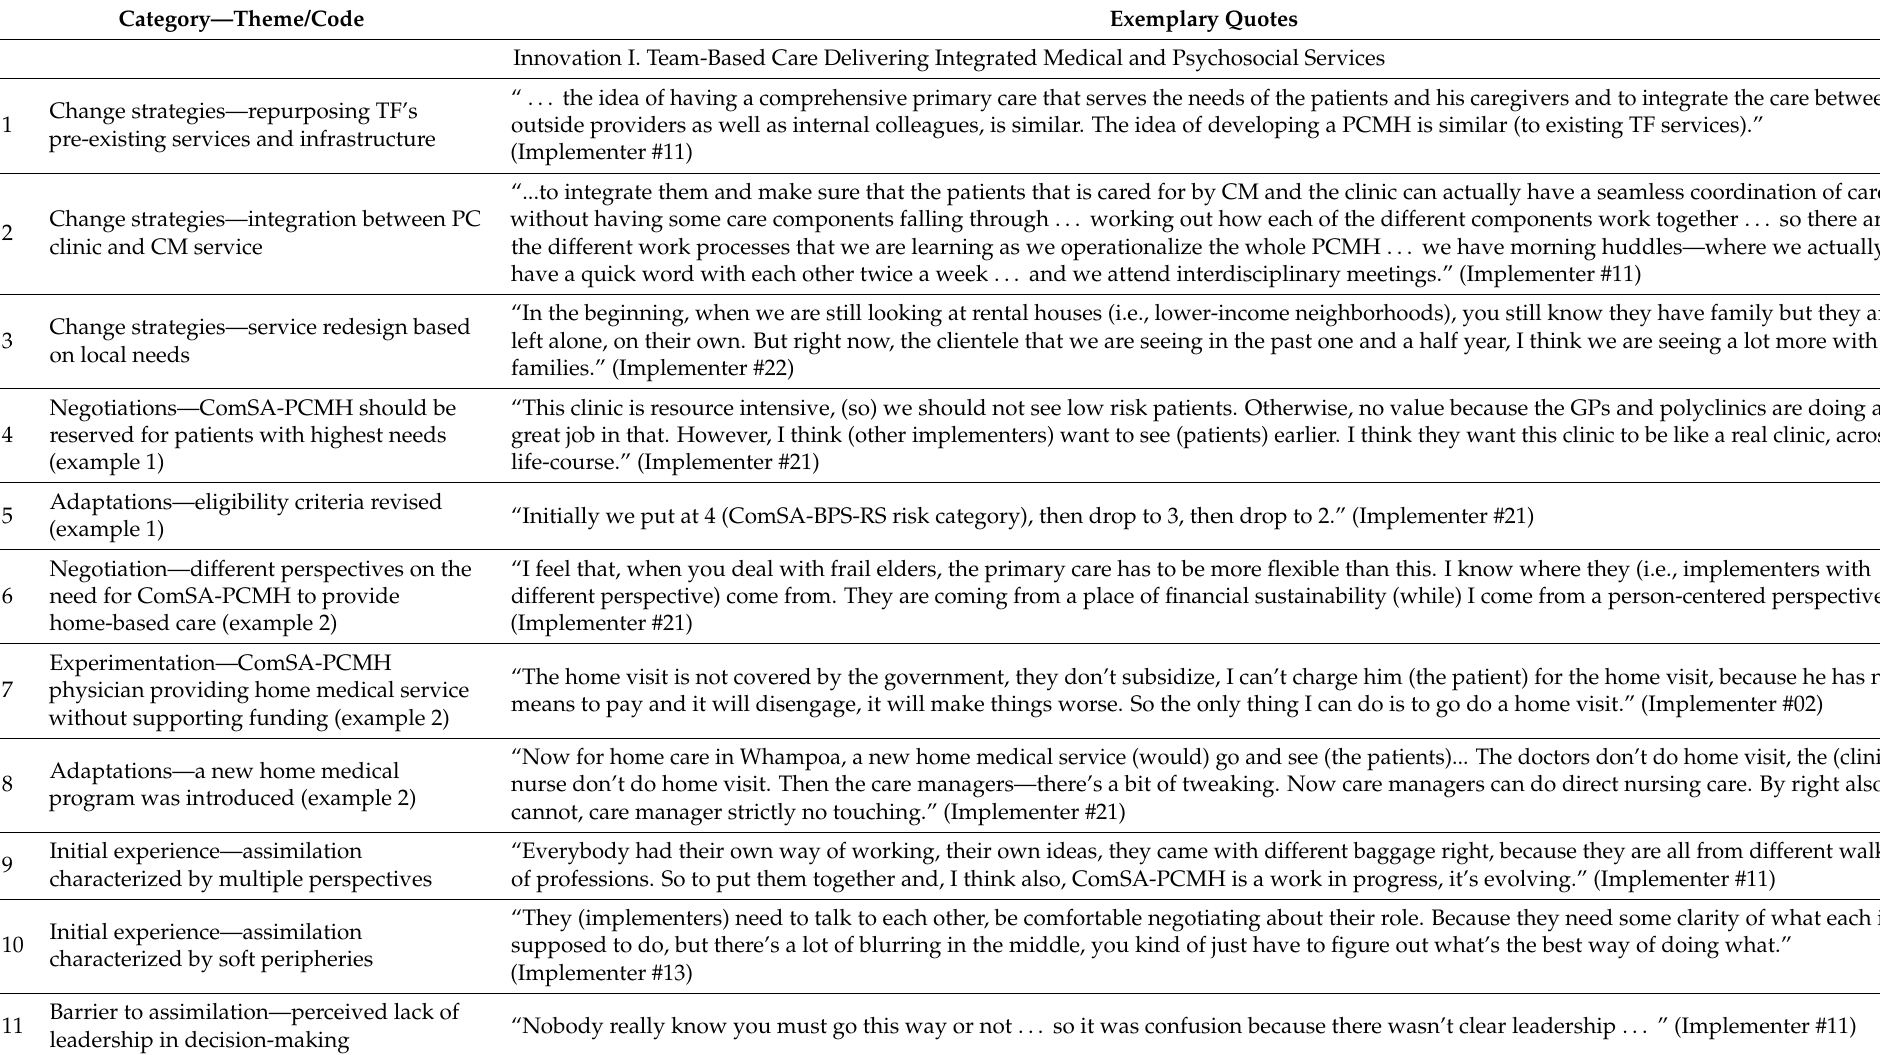
Table 1. Exemplary quotes from the